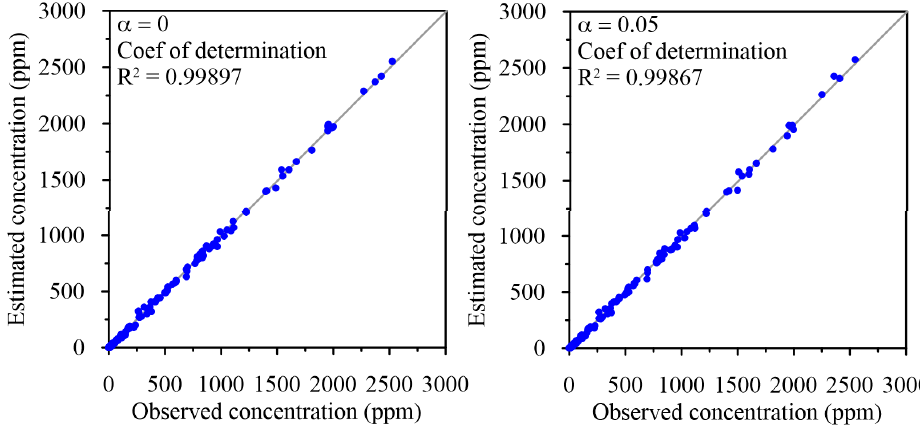
Figure 8. Recovered release histories of sources 1 and 2 in error-free data condition ( α = 0) and in error-perturbed data condition ( α = 0.05).